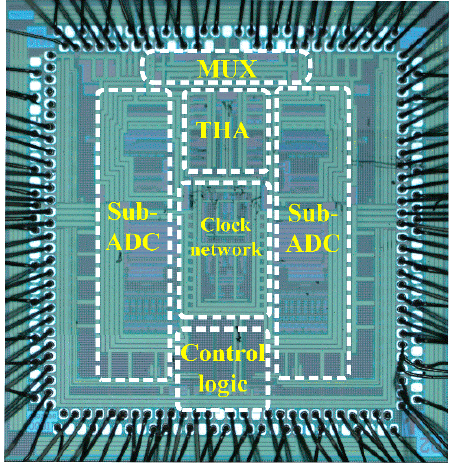
Figure 12. Micrograph of the proposed ADC.